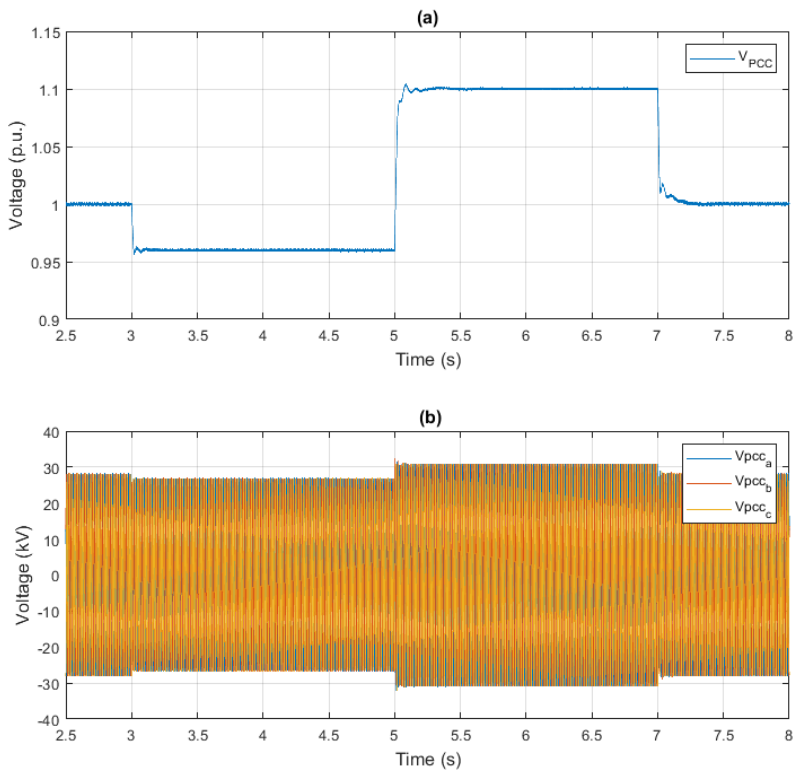
Figure 7. ( a ) The offshore AC voltage magnitude during voltage command change ( b ) the instantons voltage of offshore AC voltage.